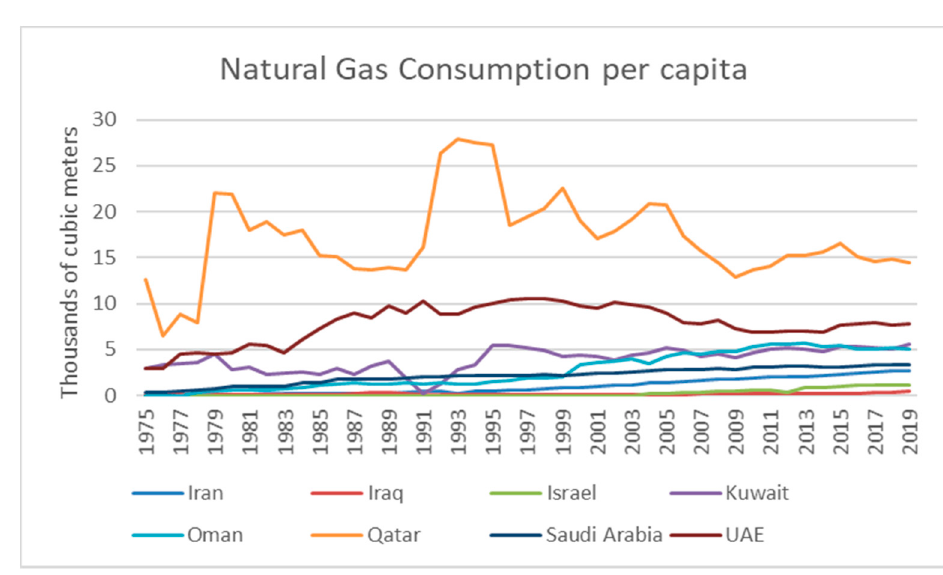
Figure 2. Natural gas